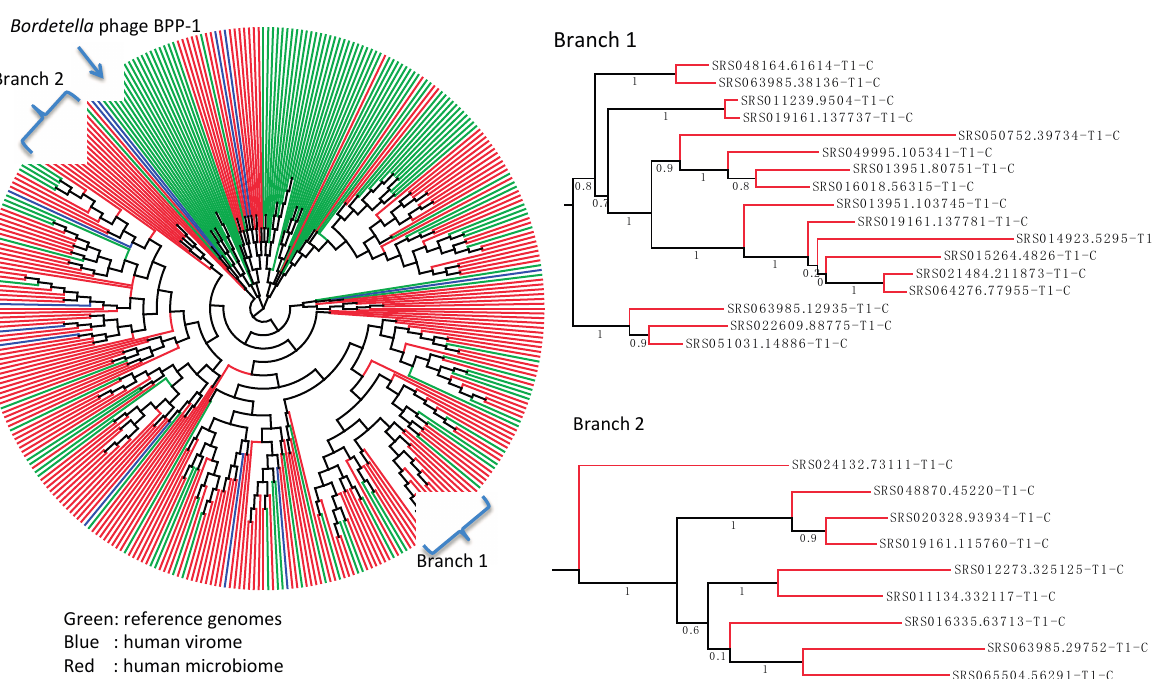
Figure 2. A phylogenetic tree of the reverse transcriptases identified from the reference genomes (shown in green) [12], human virome (blue) [16] and human microbiomes (this study; red). The RT identified from Bordetella phage BBP-1 is highlighted in the tree. The multiple alignment was done using MUSCLE [17]. The FastTree program [18] with default parameters was used to reconstruct the neighbor-joining tree, and the tree was visualized using the Archaeopteryx tree viewer [19].